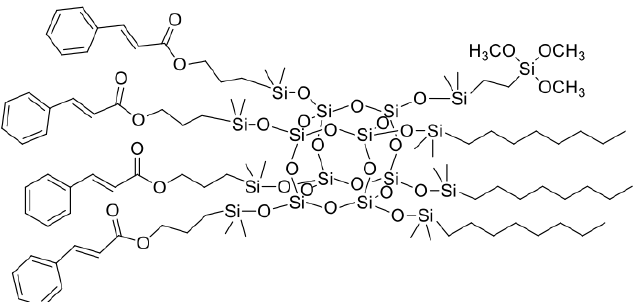
Figure 2. The chemical structure of SSQ2. Figure 3. The chemical structure of SSQ3. Figure 3. The chemical structure of